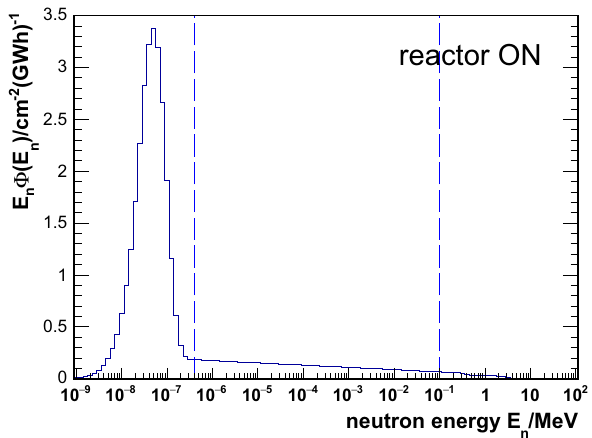
Fig. 13 Solution of the neutron energy distribution Φ ( 1 ) ( E n ) resulting from the analysis of the DS-3 data normalized to the energy emitted by the reactor